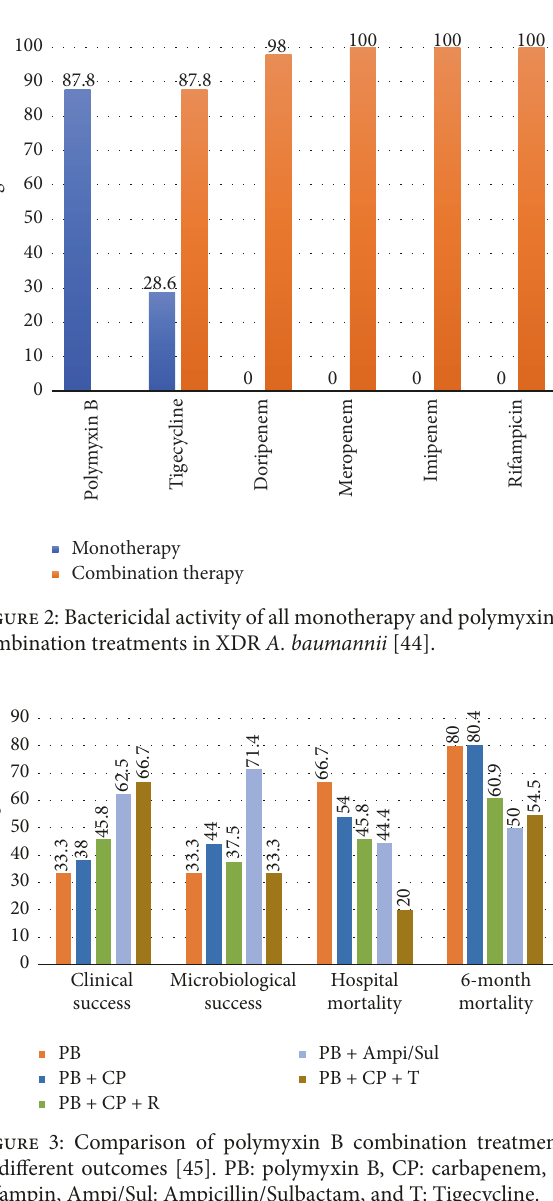
infections included A. baumannii ( 𝑛 = 34 /104), K. pneumo- niae ( 𝑛 = 25 /104), P. aeruginosa ( 𝑛 = 11 /104), and multiple organisms ( 𝑛 = 34 /105). Bacteraemia was present in 5